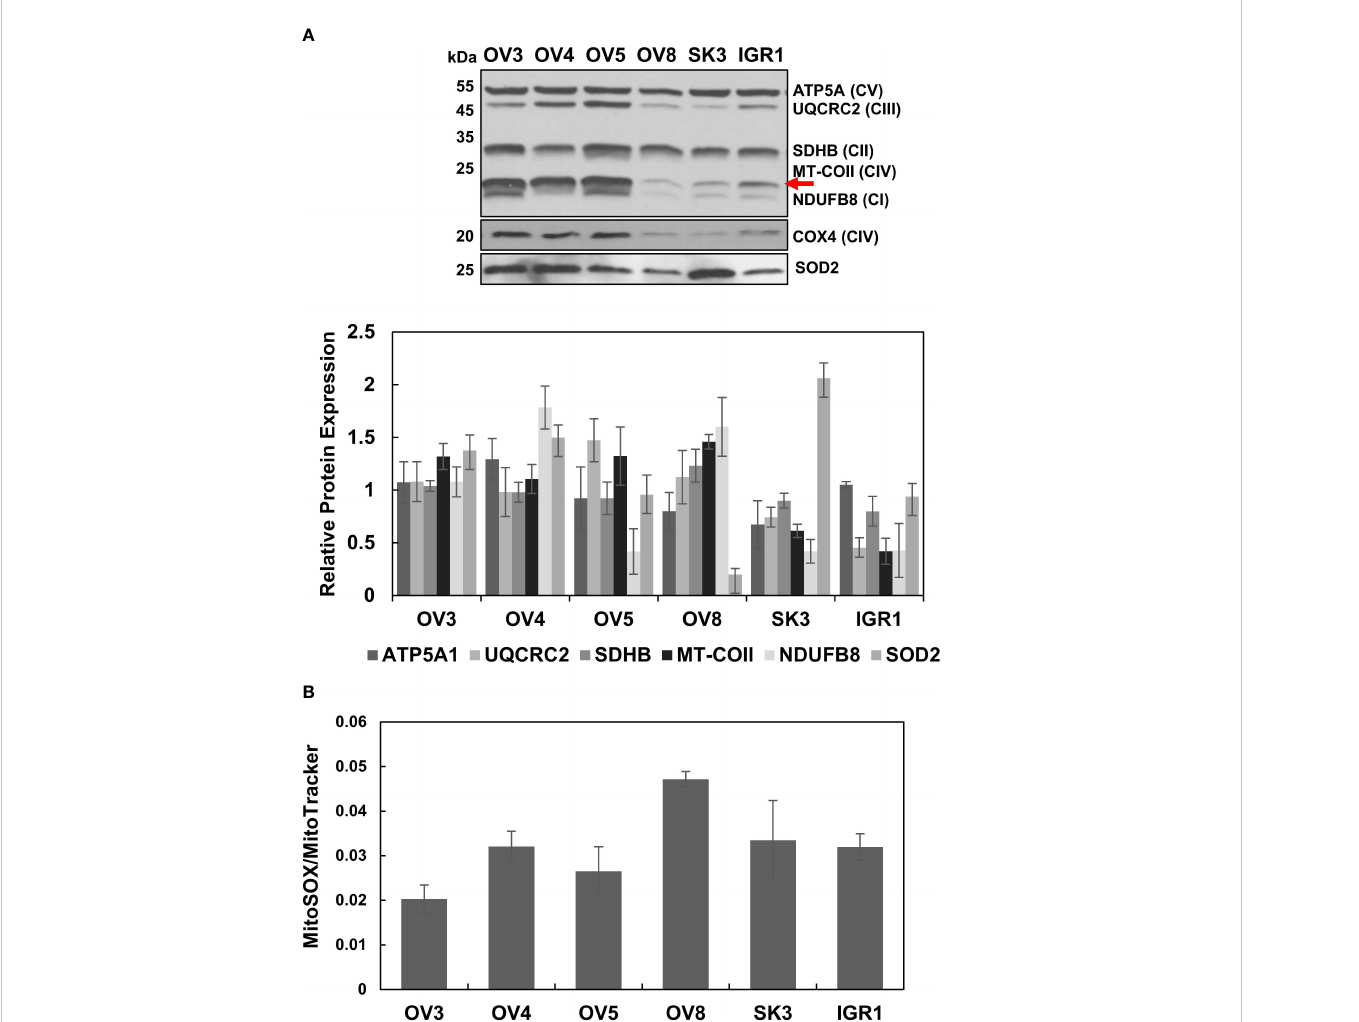
FIGURE 4 Altered OXPHOS subunit and SOD2 expressions and generation of reactive oxygen species in ovarian cancer cell lines. (A) The OXPHOS subunit and SOD2 expressions were detected by immunoblotting of lysates obtained from ovarian cancer cell lines, OVCAR-3 (OV3), OVCAR-4 (OV4), OVCAR-5 (OV5), OVCAR-8 (OV8), SKOV-3 (SK3), and IGROV-1 (IGR1) as described in Figure 1A. The red arrow shows the mt-encoded complex IV subunit, MT- COII. The relative quantitation of OXPHOS subunit and SOD2 expression represents the mean ± SD of at least three experiments. Signal intensity for each antibody was normalized to the mean of high (OV3, OV4, and OV5) and low (OV8, SK3, and IGR1) OXPHOS expressing cell lines and Ponceau S staining (Figures S2, S3). (B) mtROS and mitochondrial mass were determined by MitoSOX-Red (MitoSOX) and MitoTracker-Red (MitoTracker) stains, respectively, using fl ow cytometry of live ovarian cancer cell lines. MitoSOX/MitoTracker ratio re fl ects mtROS formation per functional mitochondrion for each cell